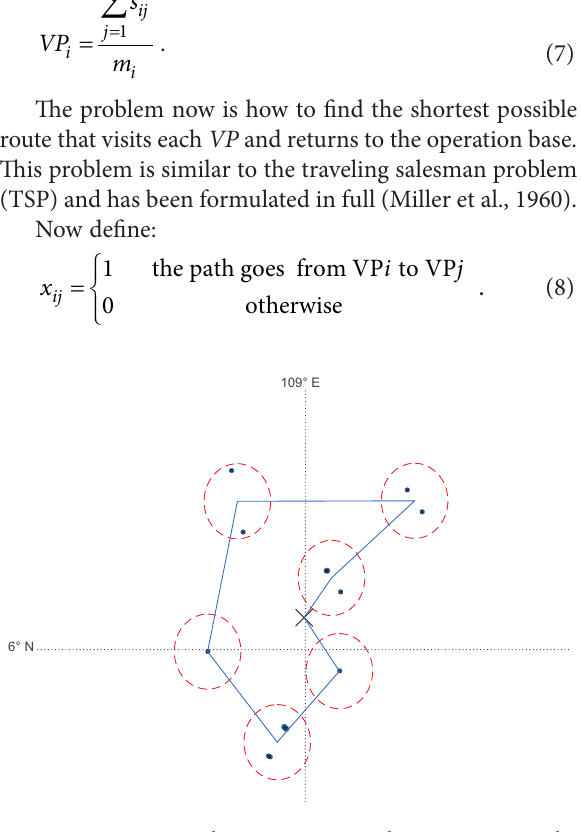
Figure 4. Grouping adjacent points to reduce waypoints and produce shorter flight